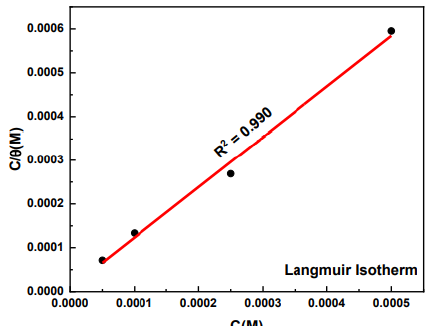
Figure 9. Langmuir adsorption isotherm fitting using the potentiodynamic polarization data at 25 ° C.